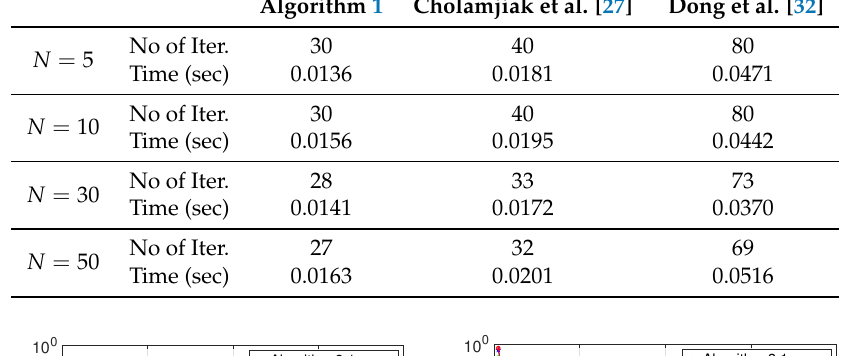
Algorithm 3.1 Cholamjiak et al alg Dong et al alg